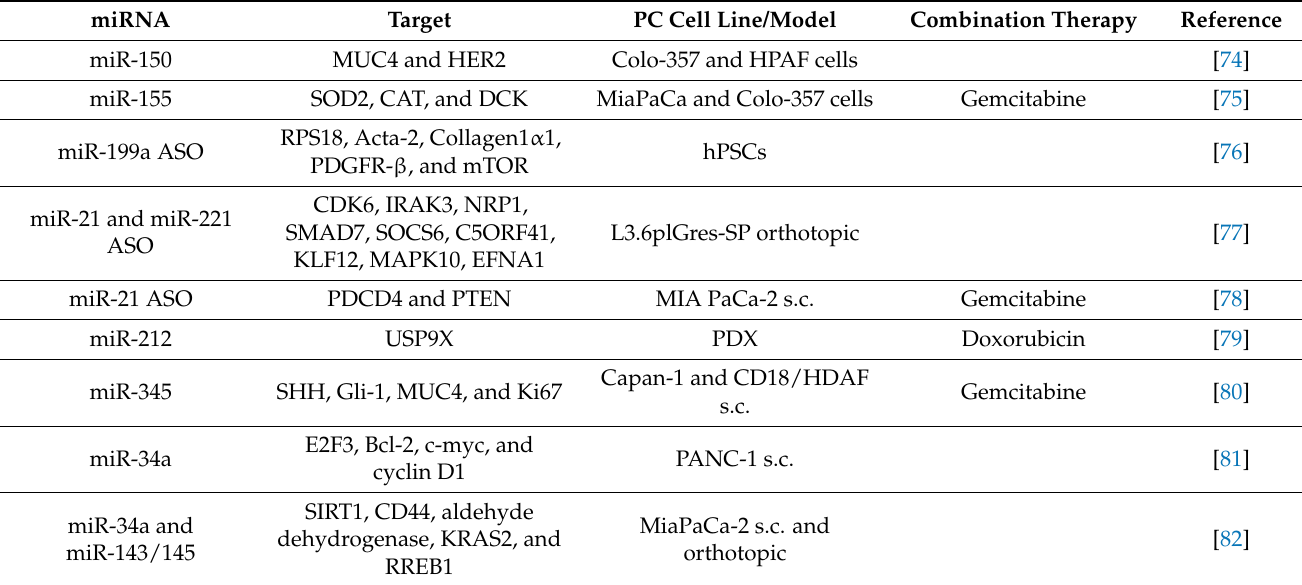
Table 3. miRNAs used for preclinical pancreatic cancer